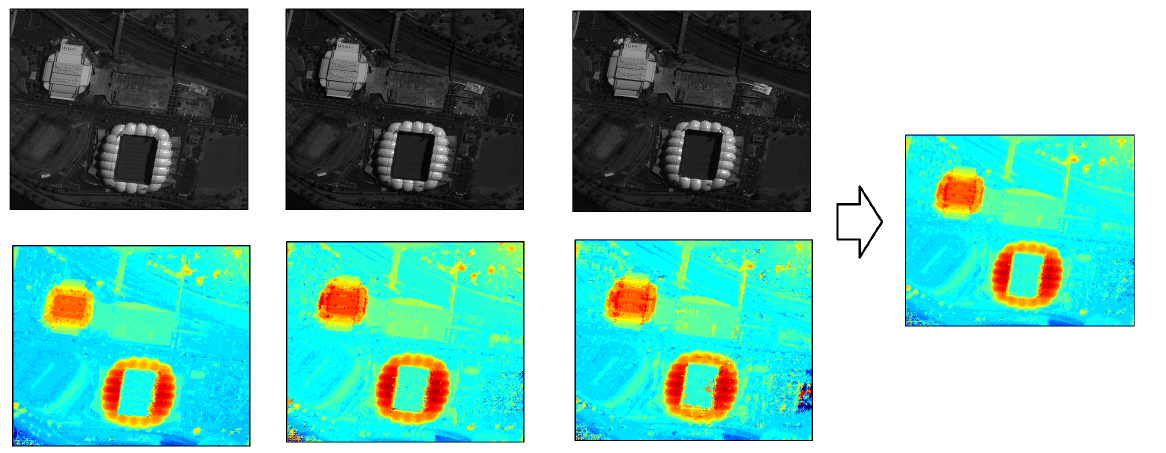
Figure 6: Top Row: Pleiades Tri-stereo images (Melbourne, Australia) Bottom: DSM generated from image pairs: 1-2, 2-3, 1-3, Right: Median